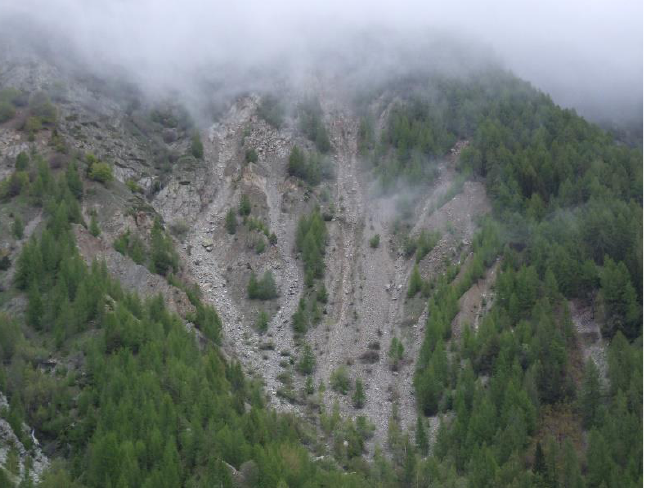
Figure 6. Present-day slope degradation processes on the left slope of the Ischiator torrent. Several deep ravines are infilled by huge detrital amounts, which feed the drainage network.